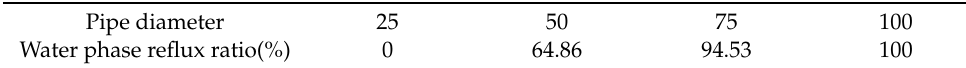
Figure 9. Distribution of oil–water velocity under different pipe diameters; The y represents the height of the bottom of the pipeline; D represents the diameter of the pipe [54]. Table 2. Water phase reflux ratio of different pipe diameters [54].